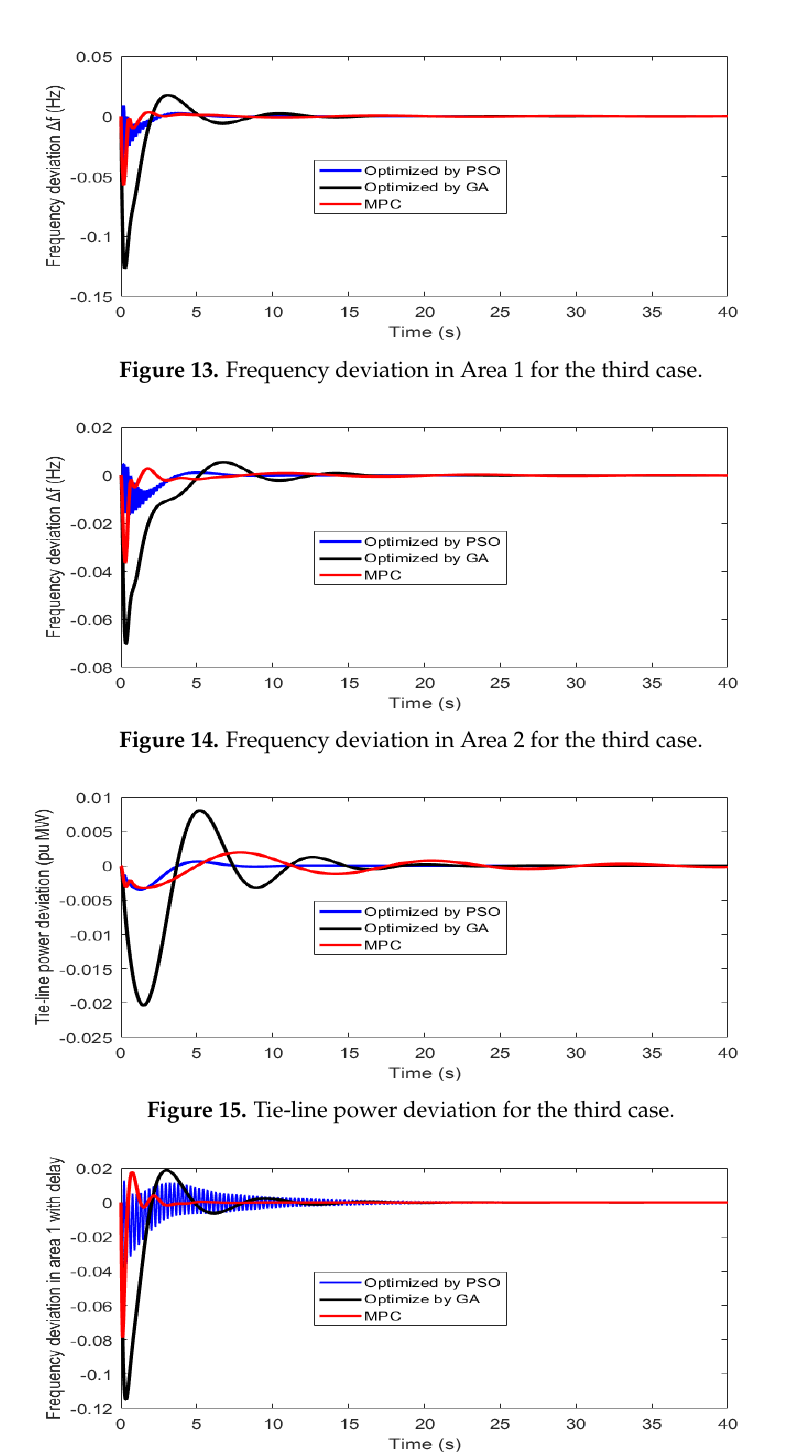
Figure 16. Frequency deviation in Area 1 for the fourth